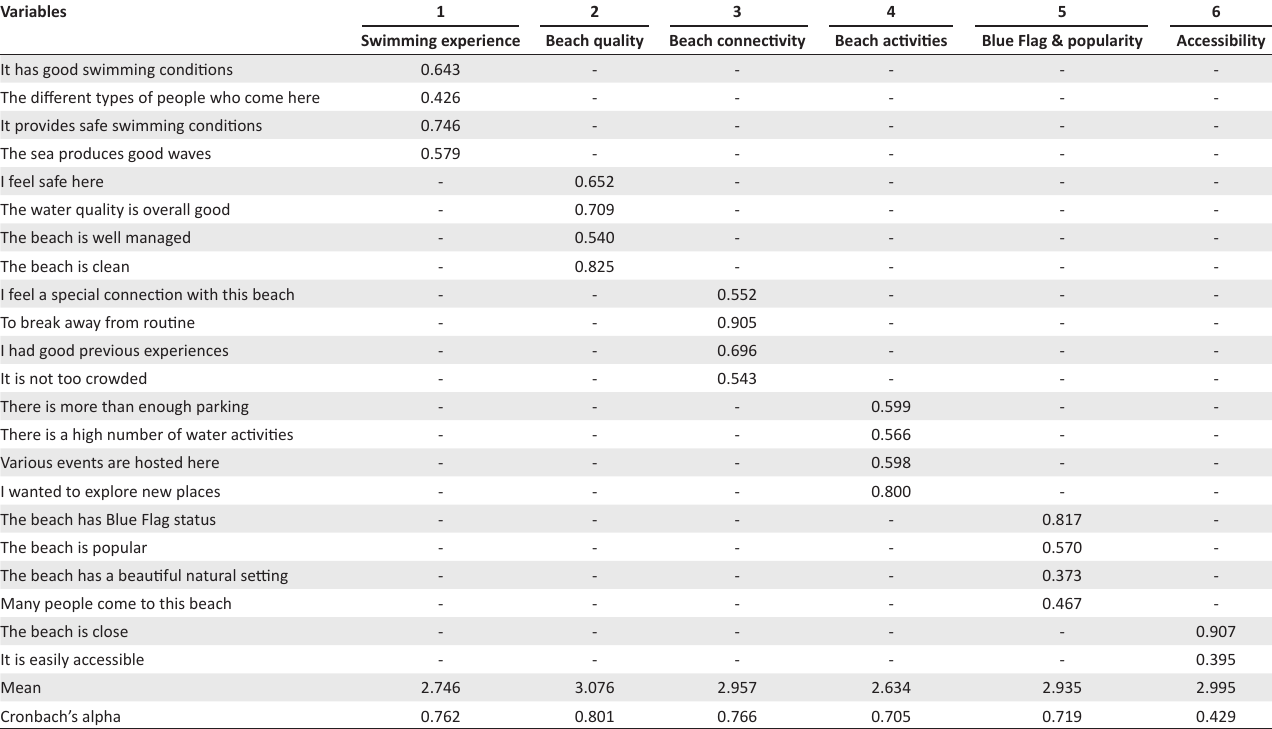
TABLE 2: Results of the principal component